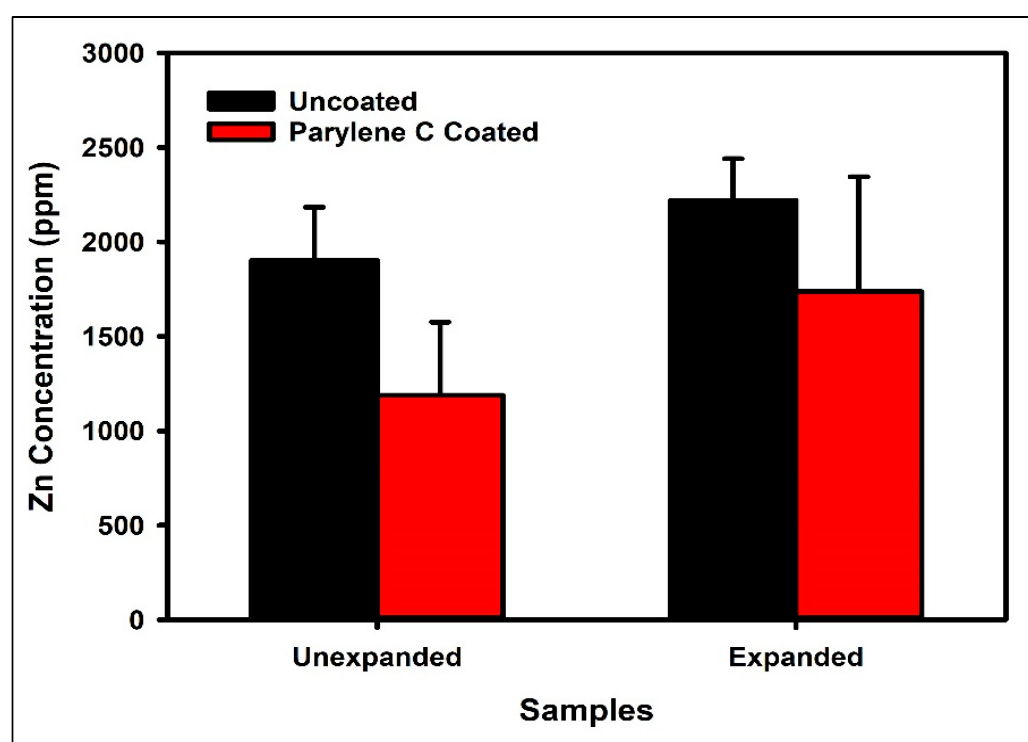
Figure 15. ICP-MS concentration of Zn 2+ in culture medium after exposure of unexpanded and expanded Zn stent samples, without and with Parylene C coating to the medium for 72 hours.